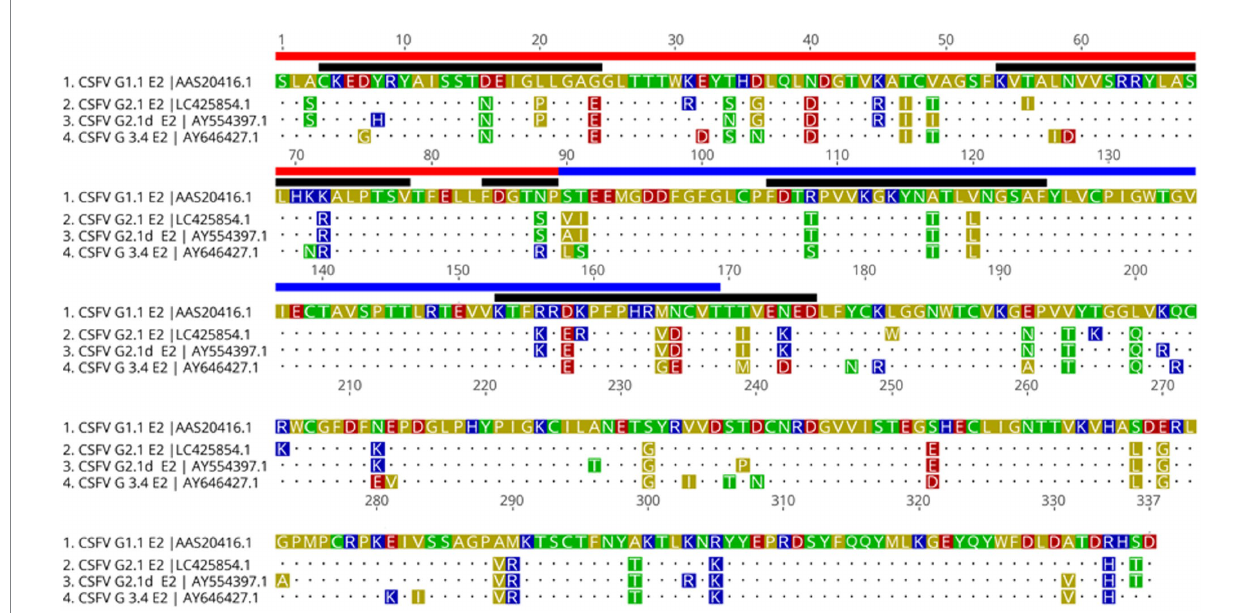
FIGURE 6 Translational alignment of different genotypes of CSFV E2 sequences. The G 1.1 sequence is used as the reference sequence. The B/C domain are underlined in red and A/D domain in blue. Known epitope region are indicated by black line. The extra predicted glycosylation site of G 2.1a, G 2.1d, and G3.4 are marked by the red